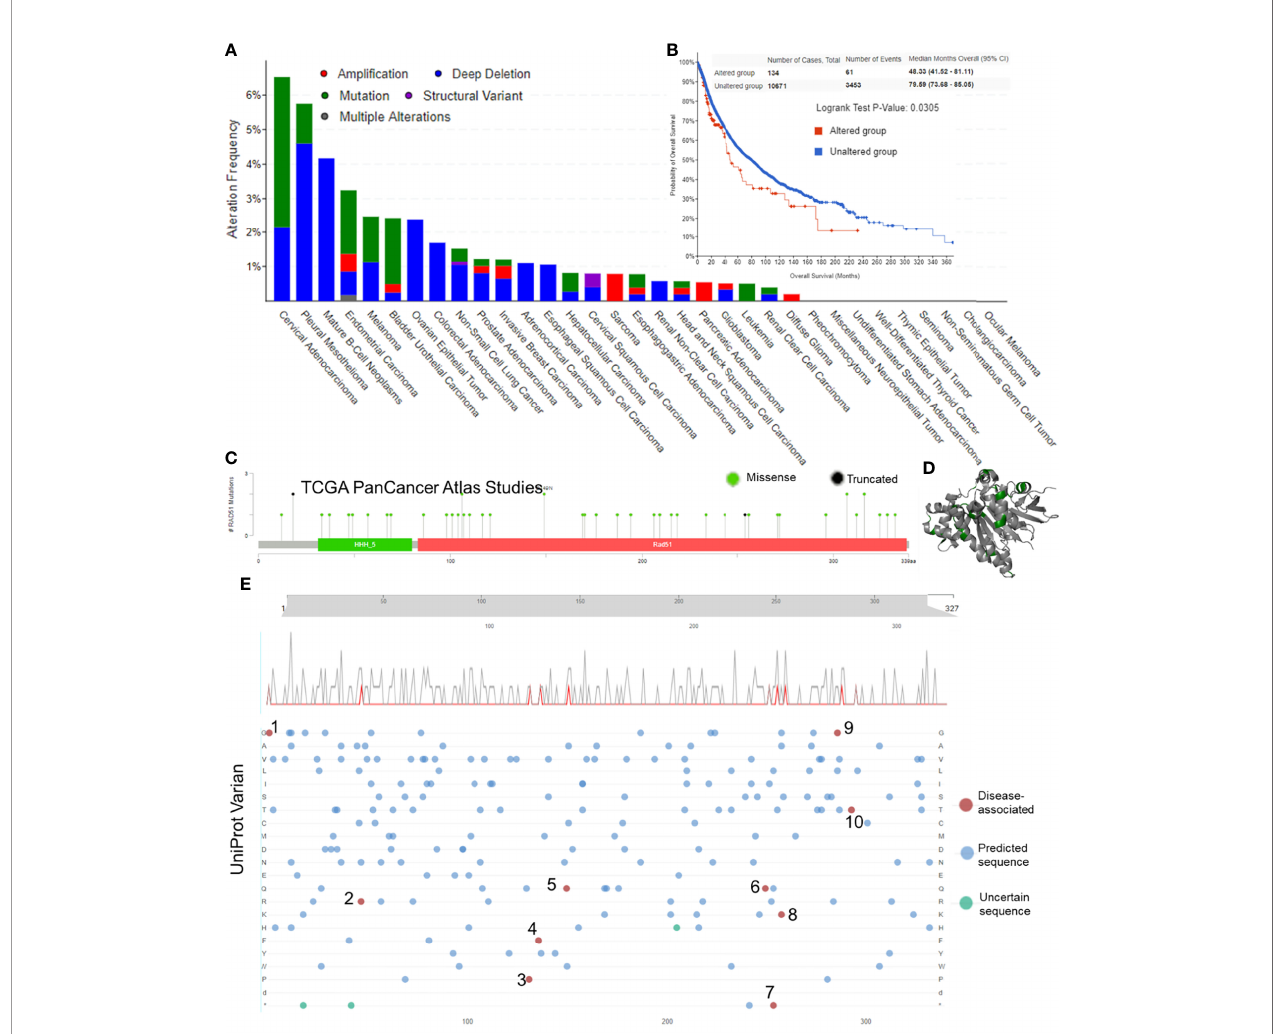
FIGURE 1 | Gene alteration of RAD51 in cancers. (A) The RAD51 genetic alteration frequencies of different types of cancers. (B) The KM plot and log-rank analysis of the overall survival of cancer patients with or without RAD51 genetic alterations. (C) Mutation pro fi le with the mutation frequencies of RAD51 in cancers. (D) The 3D structure of RAD51 protein with mutation sites (green) (PDB 5nwl). (E) Variants landscaped plot with mutated location and mutated amino acid. Top axis: amino acid position; gray curve: all mutations; red curve: disease-associated mutations; bottom plot: detailed location of the mutation (1, 2, 4, 6, 7, and 9: The disorder of congenital mirror movements; 3, 8, and 10: Fanconi anemia; 5: breast